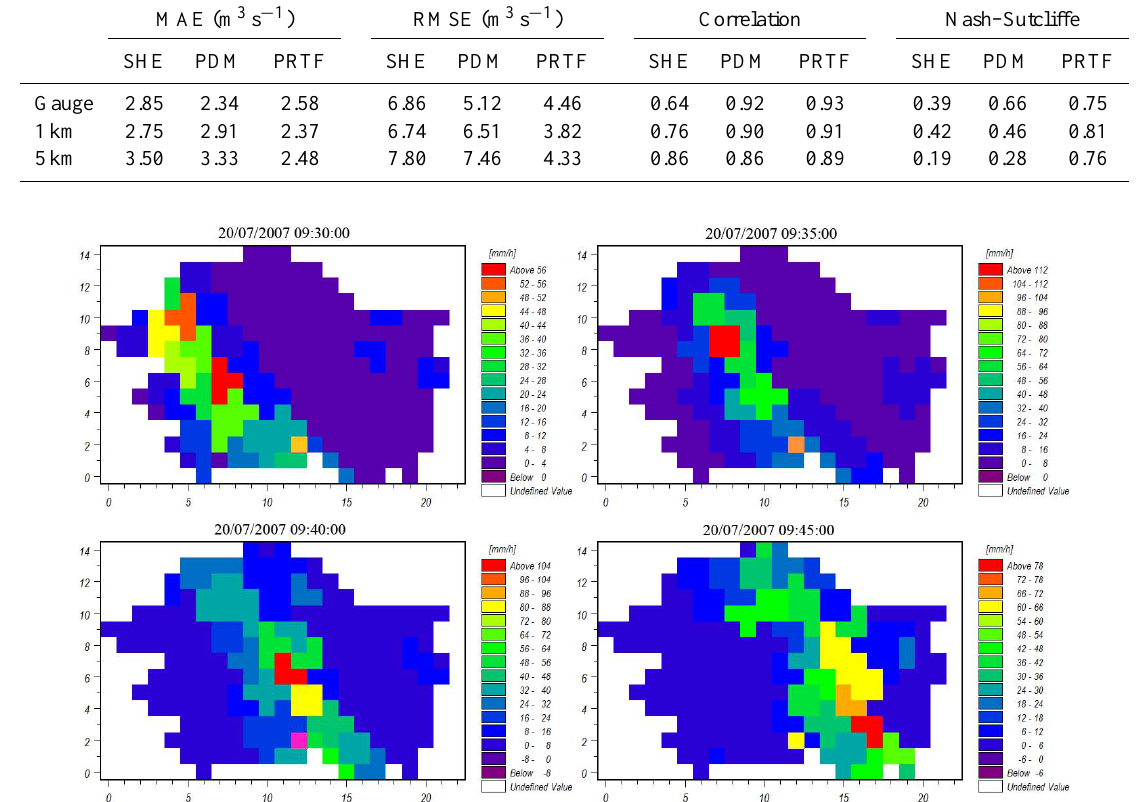
Fig. 10. Rainfall rate distribution observed by radar at four time points from 09:30 to 09:45GMT on the 20 July 2007.